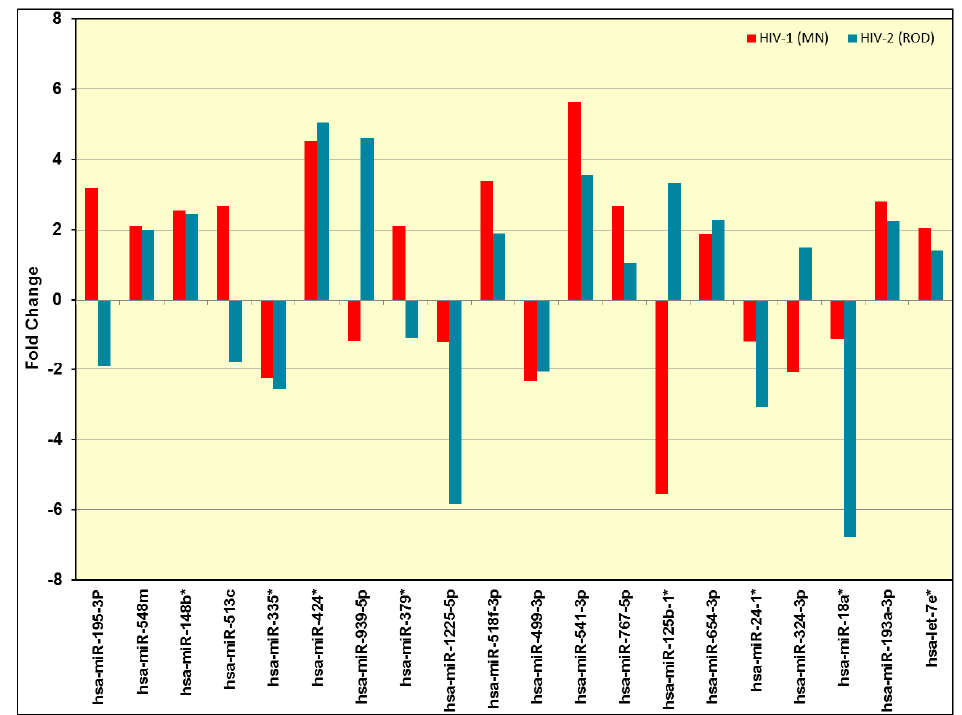
Figure 3. Identification of differentially expressed miRNAs in HIV-1 infected PBMC vs. control PBMC and HIV-2 infected PBMC vs . control PBMC using real-time PCR. We identified 20 differentially expressed miRNAs in both HIV-1 and HIV-2 infected PBMC. Red bars indicate the miRNA expression levels in HIV-1 infected PBMC and blue bars denote the miRNA expression levels in HIV-2 infected PBMC.